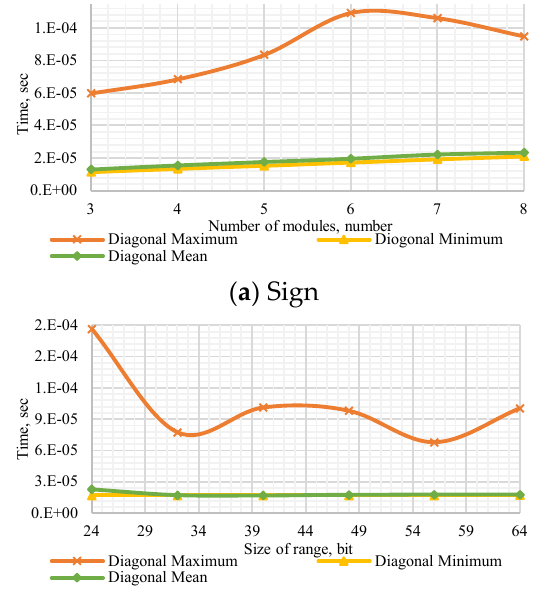
( d ) Comparison Figure A1. Performance of CRT method to ( а ) determine the number’s sign with a dynamic number of modules (cid:1868) , ( b ) compare dynamic numbers of modules (cid:1868) , ( c ) determine the number’s sign with a dynamic bit width, and ( d ) compare numbers with dynamic bit width. ( a ) Sign ( b ) Comparison